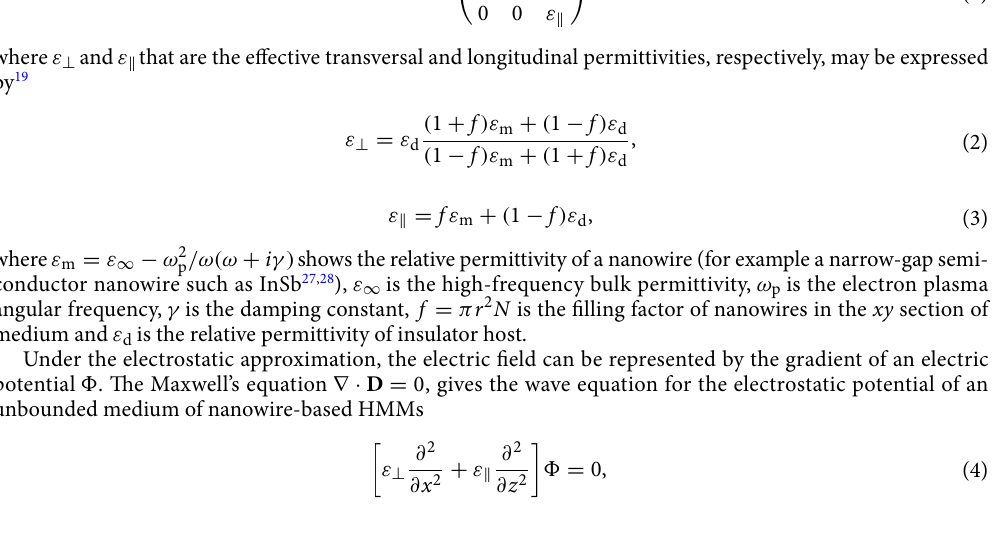
1 / √ N is the separation between the = a z a ). ( b ) Isometric view of a rectangular waveguide − ≤ ≤